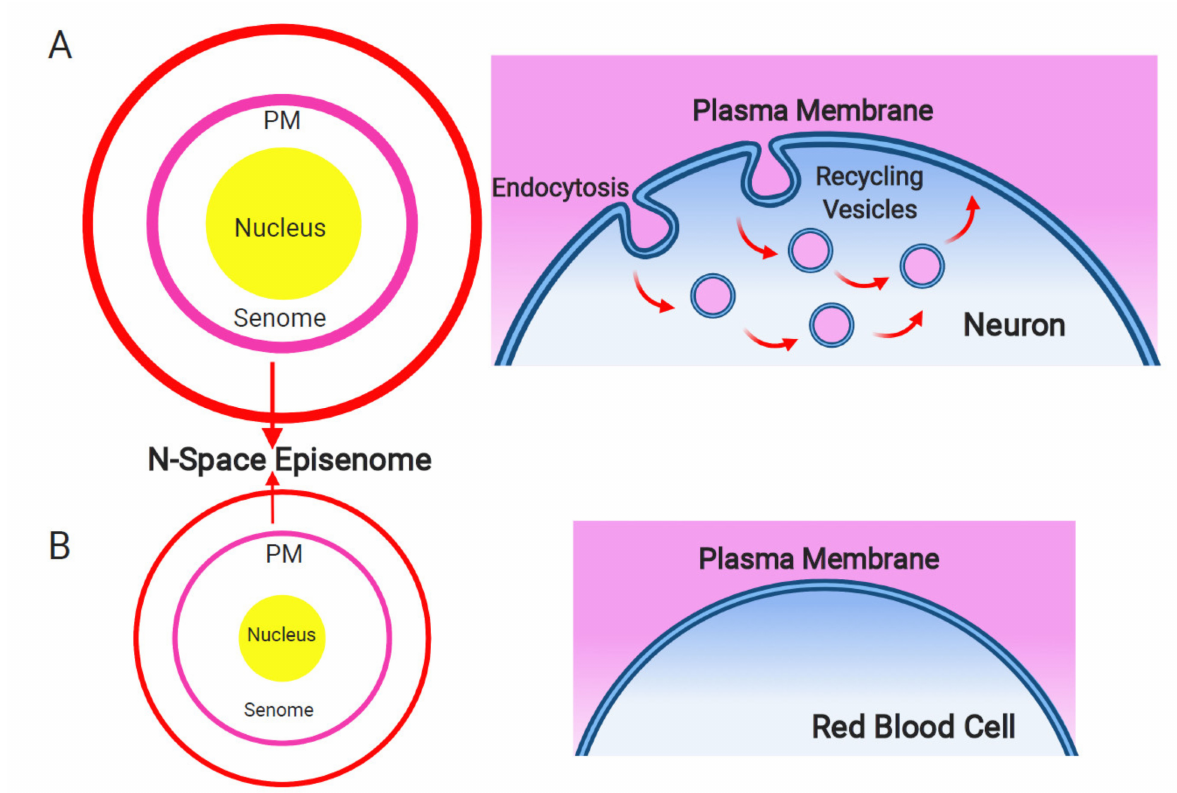
Figure 1. Plasma membrane and endosomal recycling vesicles-based nanobrain. Schematic depiction of the senome and the N-space episenome in two contrasting cells of multicellular organisms. ( A ) In the neurons and neuron-like cells, highly active endocytosis and endocytic vesicle recycling results in hypertrophied senome (lilac circle) and N-space episenome (red circle). Such cells are well-informed about their environment and are active in cell–cell communication via their plasma membrane-based nanobrains. ( B ) In the example of mature red blood cells, there are only minimal activities of endocytosis and endosomal vesicle recycling. Such cells have shrunk their senomes (lilac circle) and N-space episenomes (red circle) based nanobrains. They are socially isolated, with minimal cell–cell communication and highly reduced cellular sensory